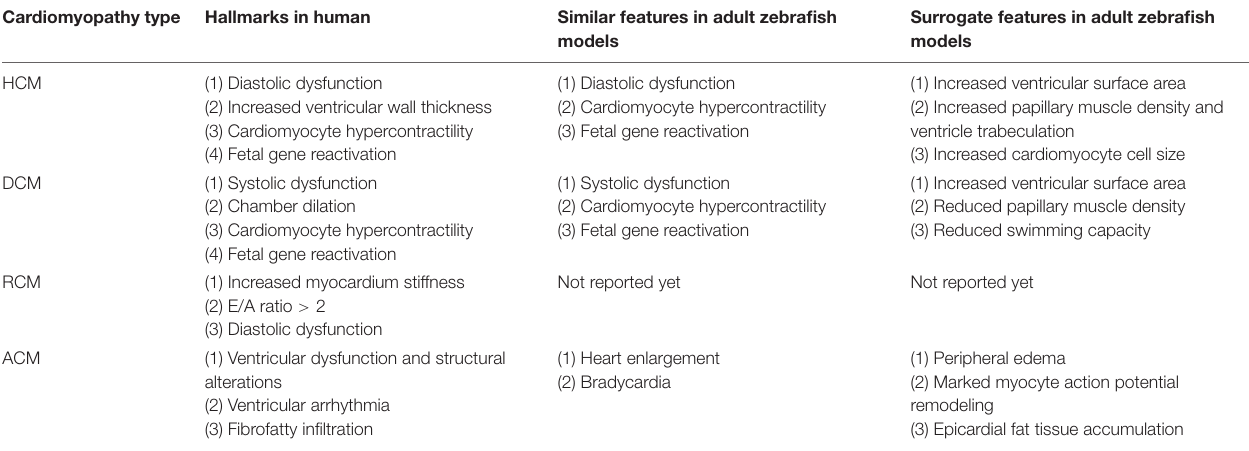
TABLE 3 | Phenotypic characteristics of inherited cardiomyopathies between human and adult zebrafish models. Cardiomyopathy type Hallmarks in human Similar features in adult zebrafish